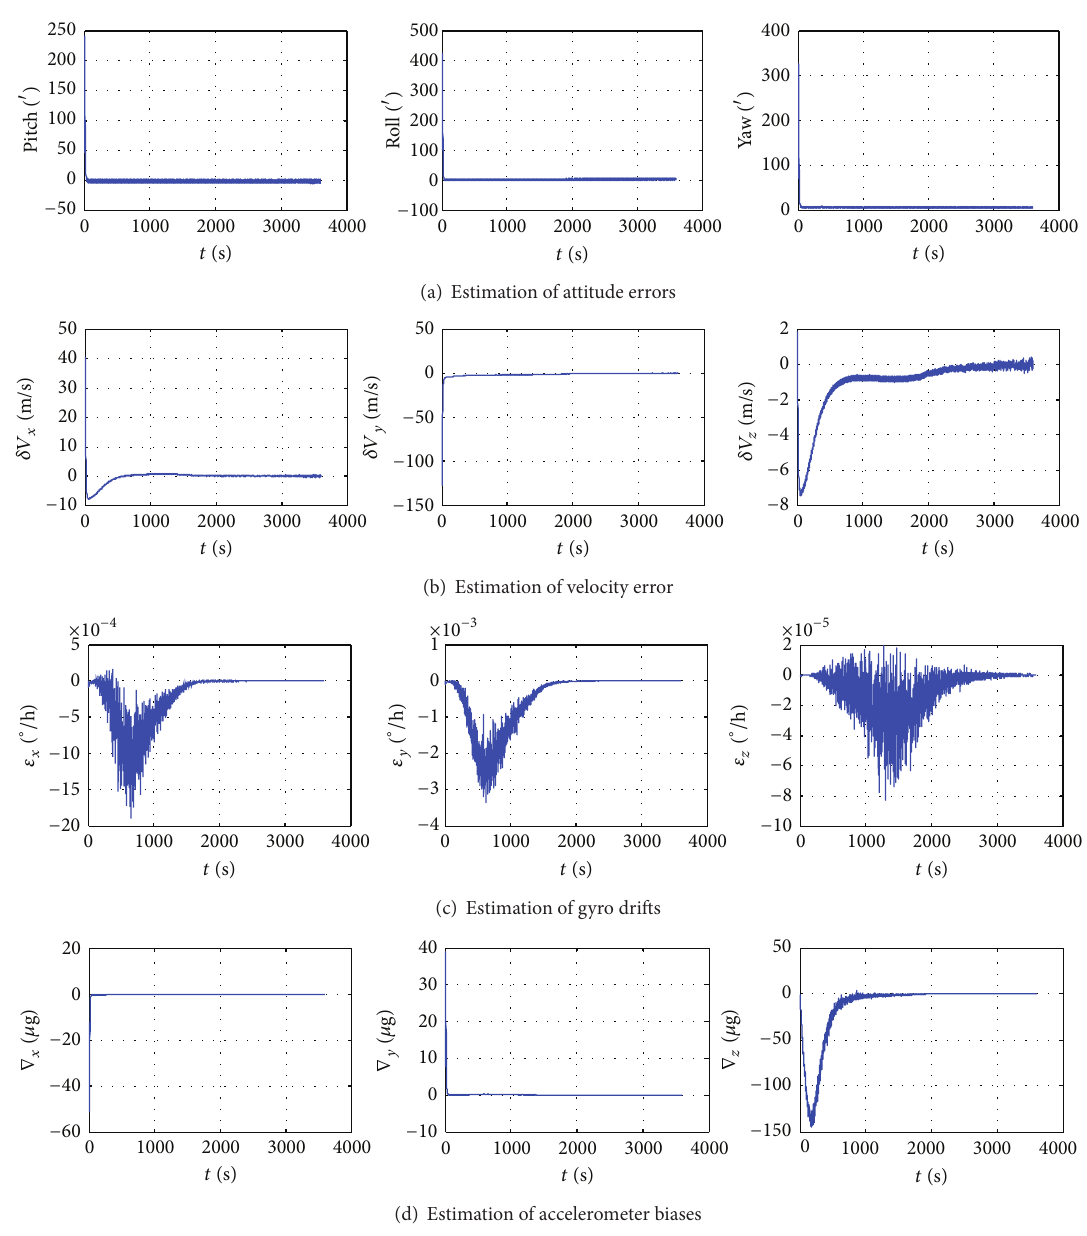
Figure 3: The simulation results of 𝐻 ∞